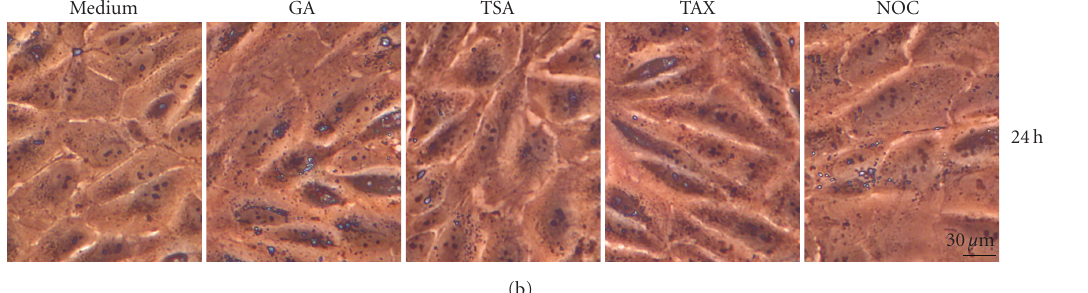
Figure 1: (a) Phase contrast micrographs of control (C) cells, and cells exposed to 5 μ M MG-132 (MG) or 0.25 μ M geldanamycin (GA) or 1 μ M trichostatin A (TSA) or 1 μ M taxol (TAX) or 5 μ M nocodazole (NOC) for 24 hours. In addition, the cells were treated simultaneously with GA or TSA or TAX or NOC and MG-132 for up to 24 hours, (b) and then allowed to recover under the indicated conditions for 24 hours. Protein aggregates are seen as dark granular deposits in perinuclear space (downward arrows), the examples of clear cytoplasm are marked with upward arrows. Arrows from left to right indicate disperse